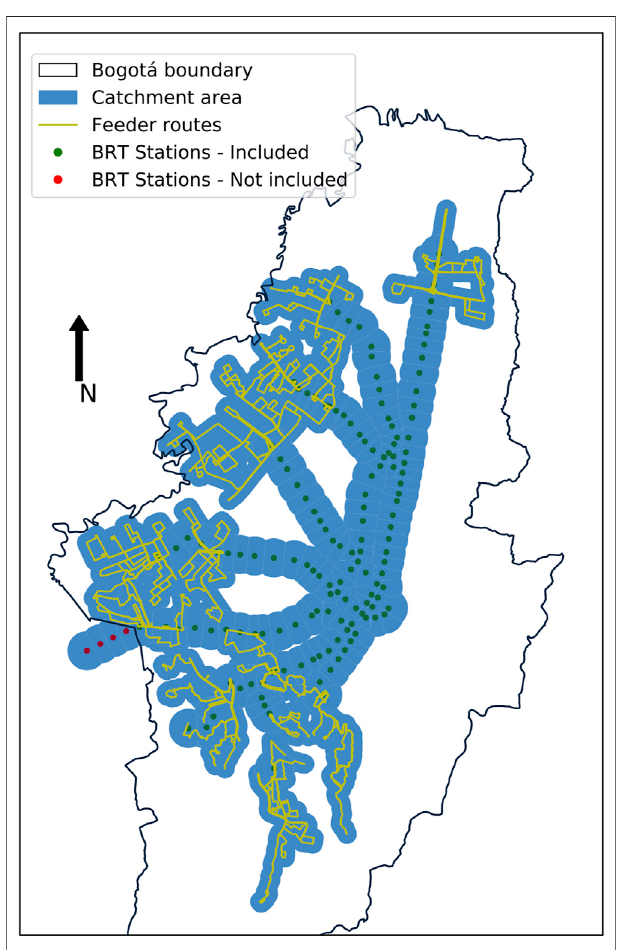
FIGURE 3 | BRT stations, feeder routes and catchment